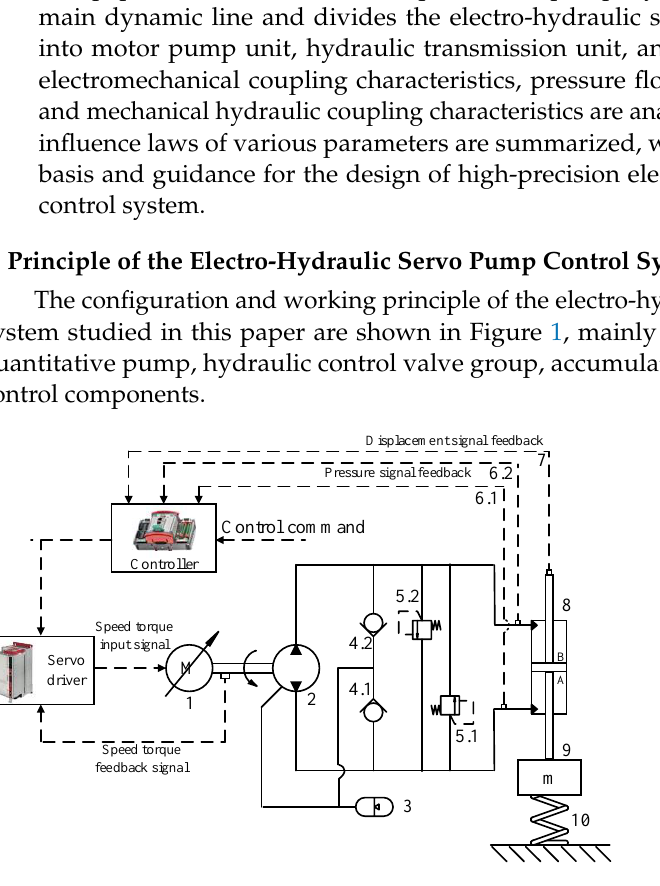
Figure 1. Working principle diagram of the electro-hydraulic servo pump control system. 1: Servo motor, 2: positive displacement pump, 3: oil replenishment accumulator, 4.1: A-chamber check valve, 4.2: B-chamber check valve, 5.1: A-chamber check valve, 5.2: B-chamber check valve, 6.1: chamber A pressure signal, 6.2: chamber B pressure signal, 7: displacement signal, 8: symmetrical hydraulic cylinder, 9: fast load quality, and 10: load